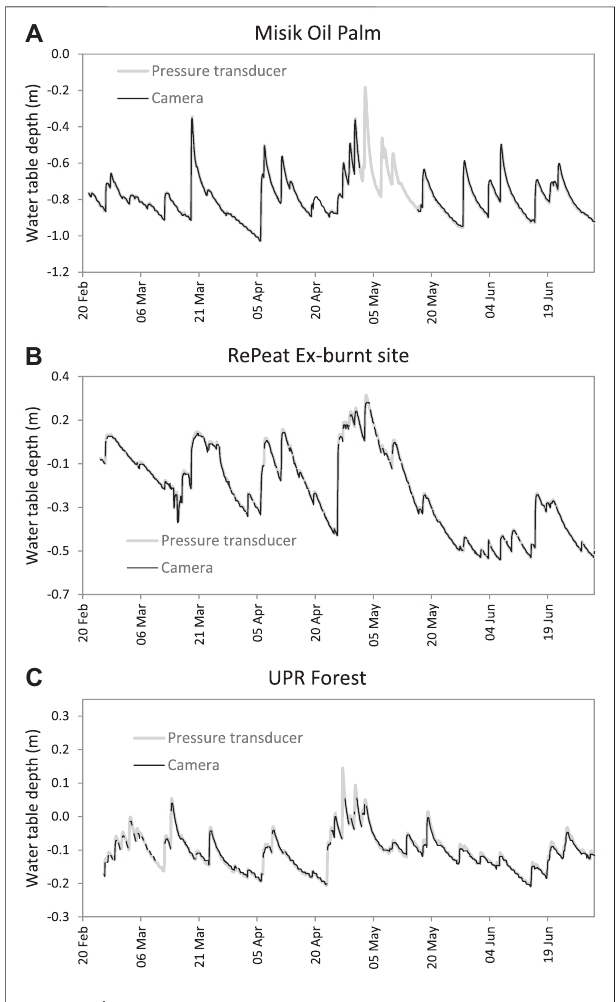
FIGURE8| Hourlytimeseriesofwatertabledataderivedfromcamerasand pressure transducers over a 4-month period from February to June 2020). Note that y -axes vary between panels depending on the observed range of variation at the site, to facilitate comparison of logger and camera performance. (A – C) arethereassiteidenti fi erstoenablespeci fi cpanelstobereferencedfromthetext.